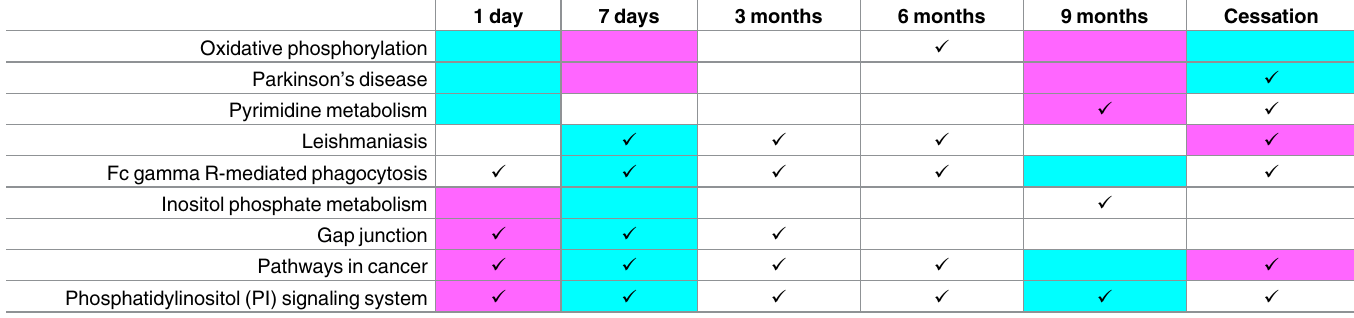
Table 3. Pathways overlapping between transcriptomic and metabolomic data. Checkmarks signify significantpathwayperturbationin metabolomic data ( p < 0.05), pink shadingdenotes enrichment for upregulated genes in that pathwayin CS-exposedmice; blue shadingindicatesenrichment for downregu- lation in CS-exposedmice (FDR (cid:20) 0.10). Perturbations indicatedby shadedfields under the “Cessation”column persisted followingcessation when compared to AC